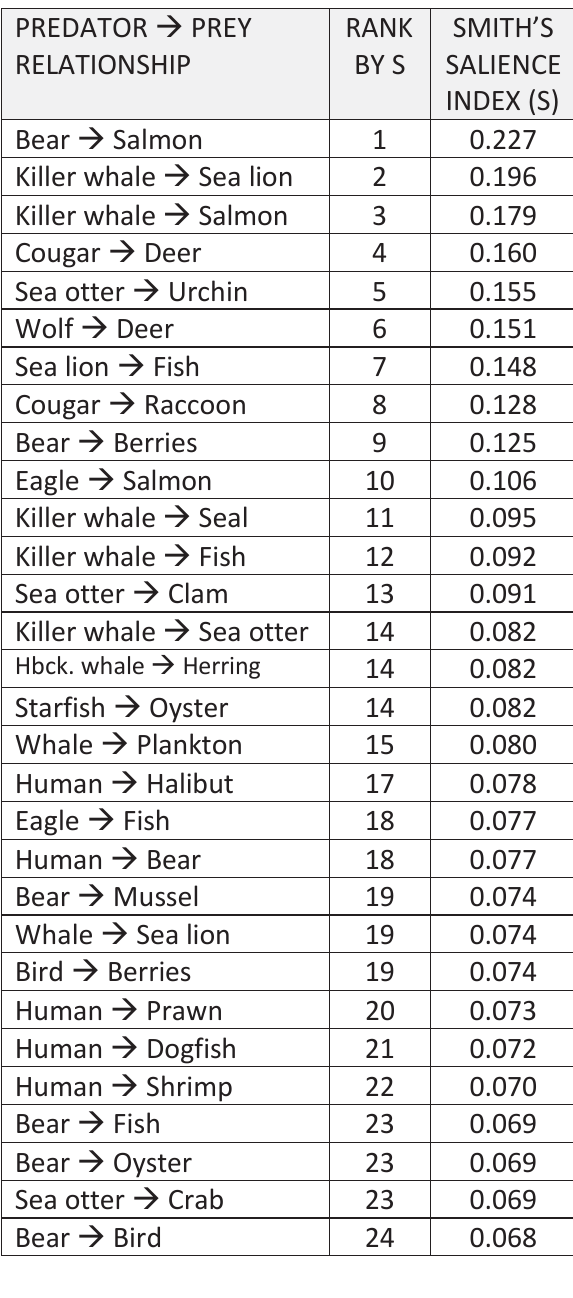
Most cognitively